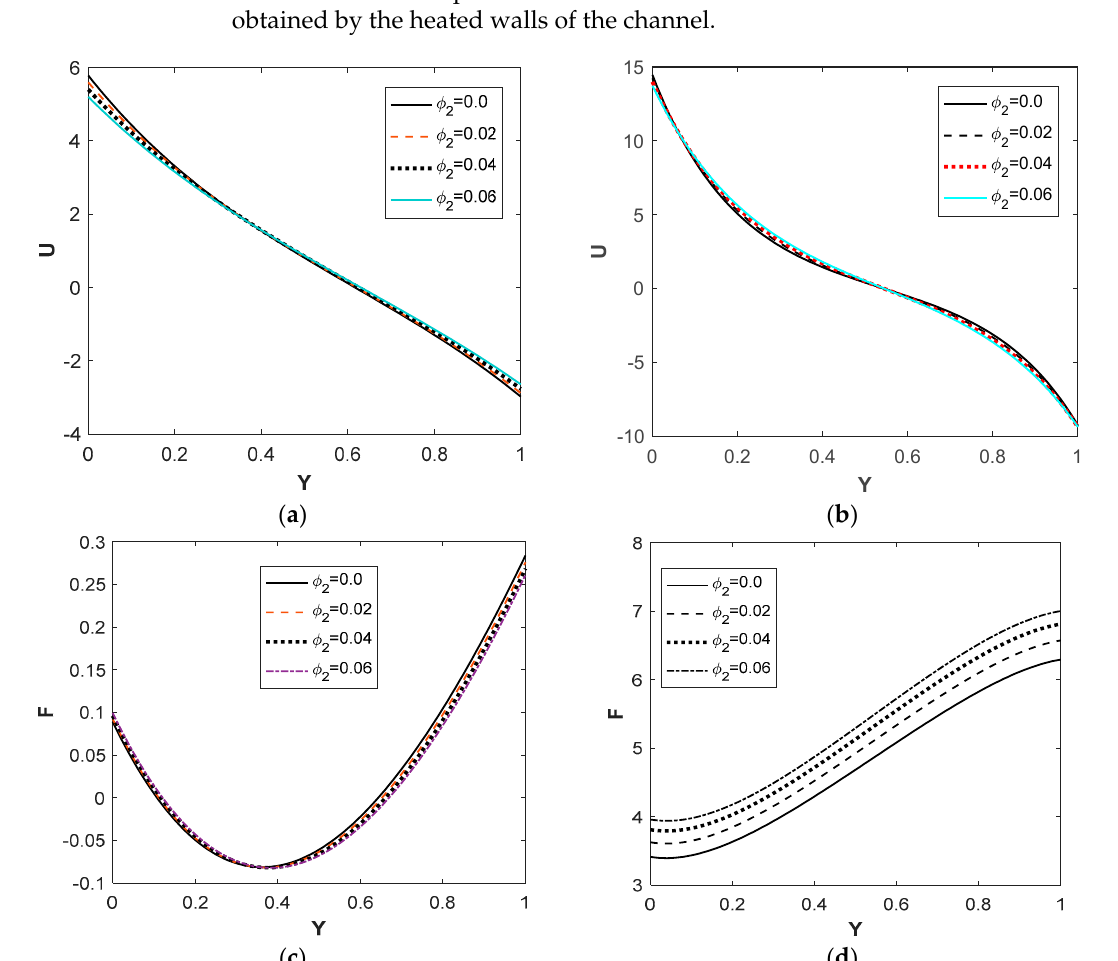
Figure 4. Velocity and temperature profiles for Pe = 1, γ = π different concentrations of Cu-nanoparticle volume fraction.